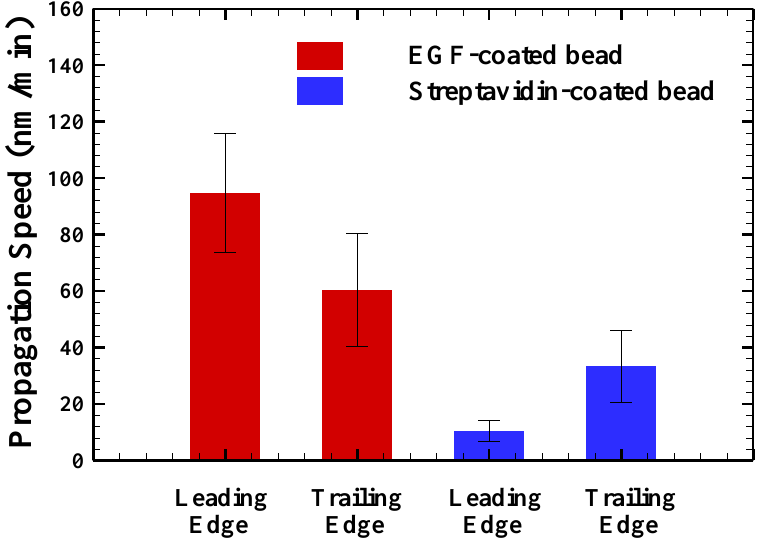
Figure 6. The effect of the EGF-coated bead and the streptavidin-coated bead on the propagation speeds at the leading ( |𝑉 𝐿 ⃑⃑⃑ | ) and trailing ( |𝑉 𝑇 ⃑⃑⃑⃑ | ) edges.